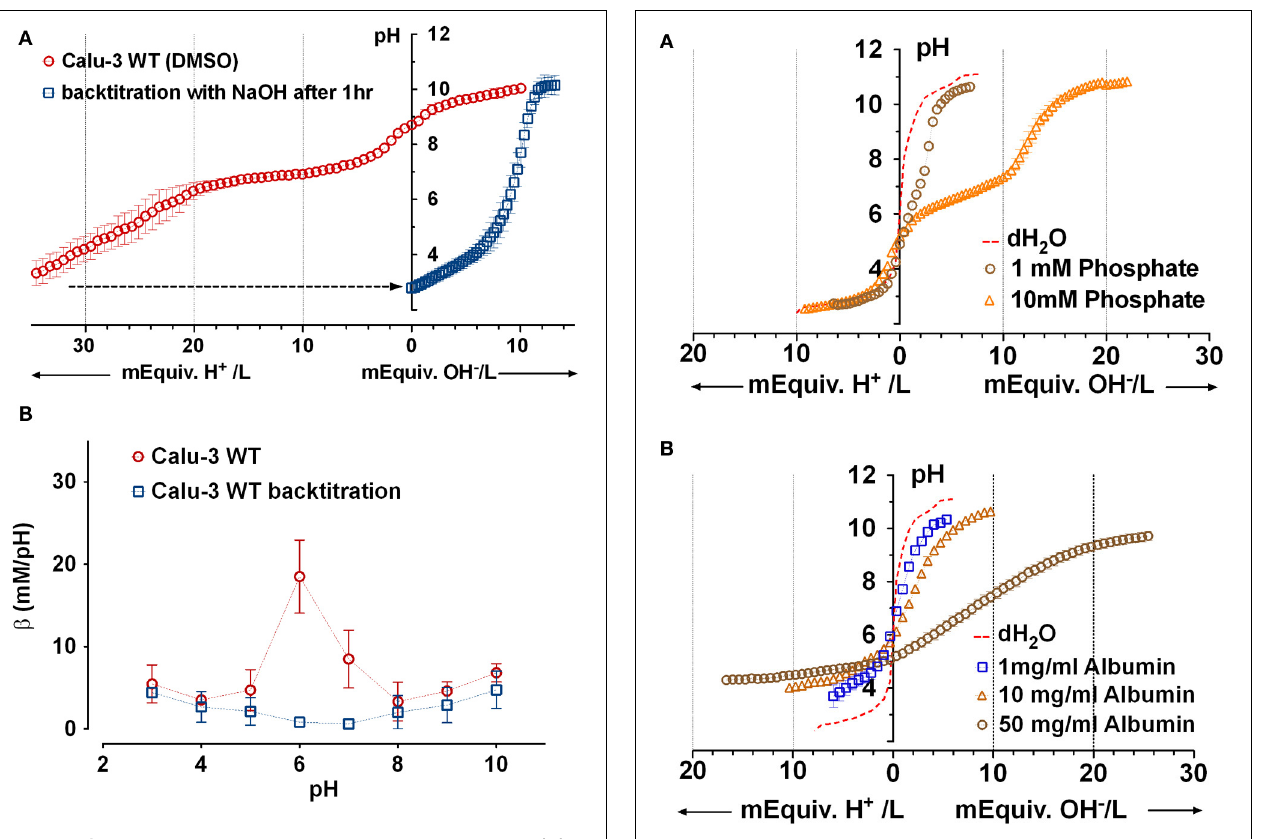
FIGURE 5 | Microtitration curves for phosphate and albumin at relevant concentrations. (A) Curves obtained with 1 and 10mM phosphate solutions. Dashed red line shows results with distilled water. (B) Microtitration curves obtained with albumin. Means ± SD; n = 4